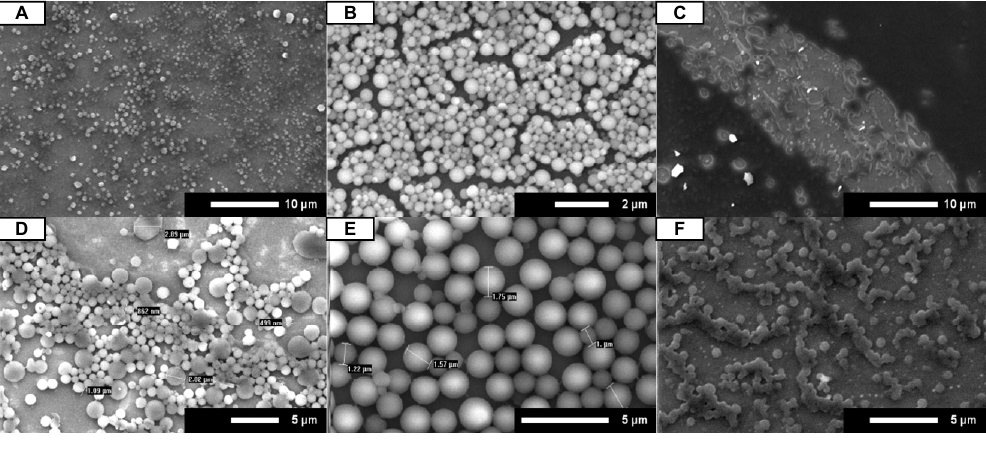
Figure 3. SEM images for A (A–C) and B (D–F). Peptoids were dissolved in 4:1 isopropanol:water and dried under open air conditions. Peptoids were administered by pipette spot (A and D), full coverage (B and E), and dipping (C and F). Scale bars are as indicated.